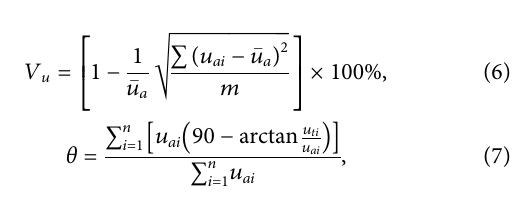
Frontiers in Energy Research |